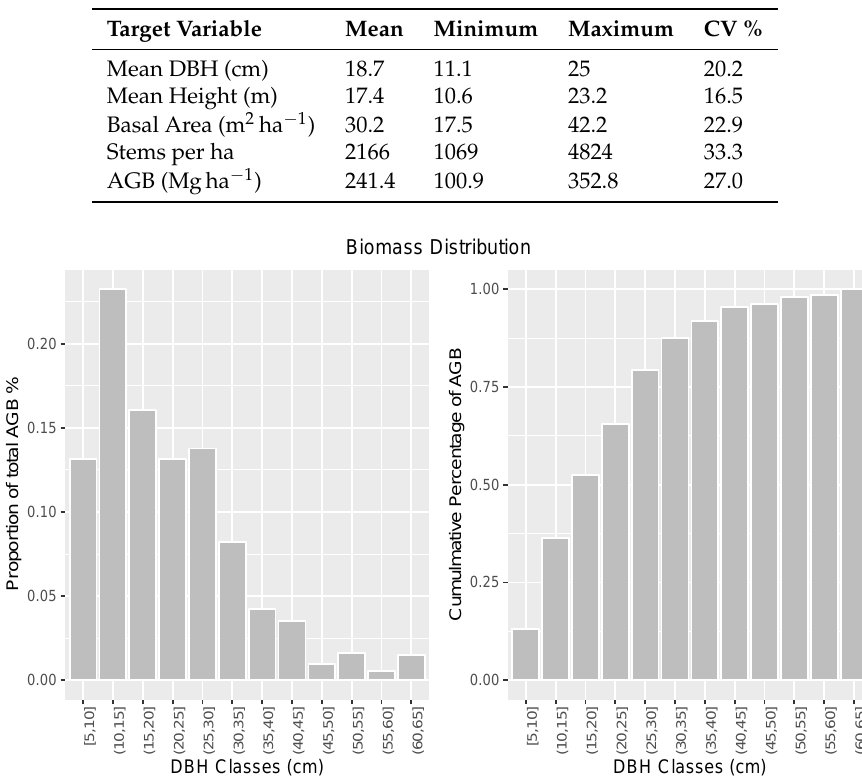
Figure 3. Photo of the complex vertical forest structure of the study area in Sebangau forest, Kalimantan. Table 2. Descriptive statistics of the plot level inventory results from the HIL plots ( n = 34) including the Coefficient of Variation (CV).